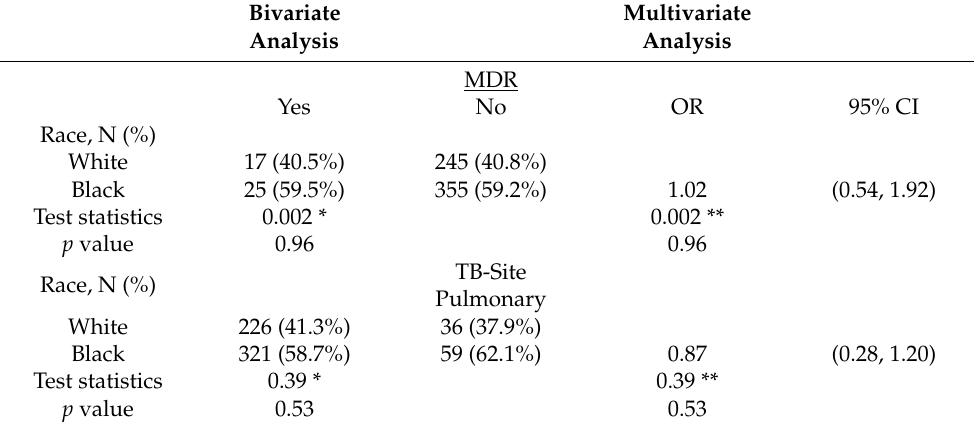
Multivariate Analysis